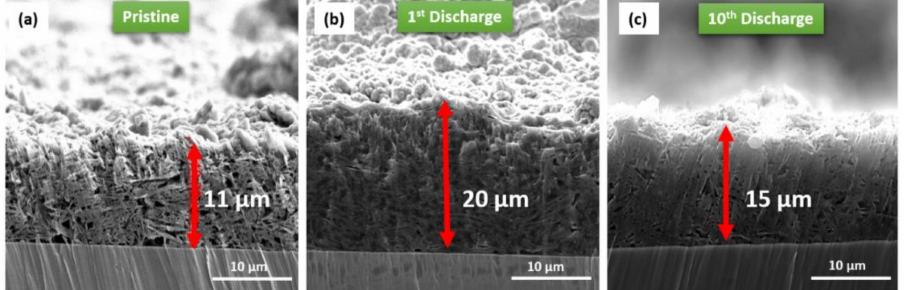
Figure 7. Cross section SEM images of the e-BMW ion milled electrodes ( a ) pristine ( b ) after the 1st discharge (0.005 V) and ( c ) after the 10 th discharge (0.05